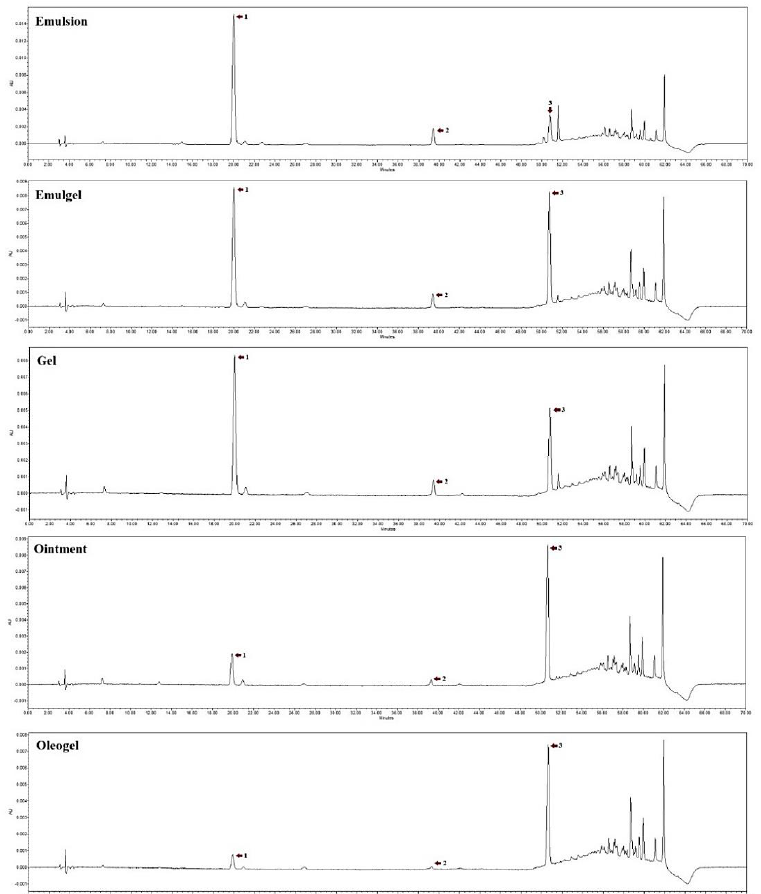
Figure 3. HPLC chromatogram of individual phenolic compounds from semi-solid forms. Analytes established at λ = 320 nm, and λ = 360 nm . 1 — chlorogenic acid; 2 — rutin; 3 — quercetin.